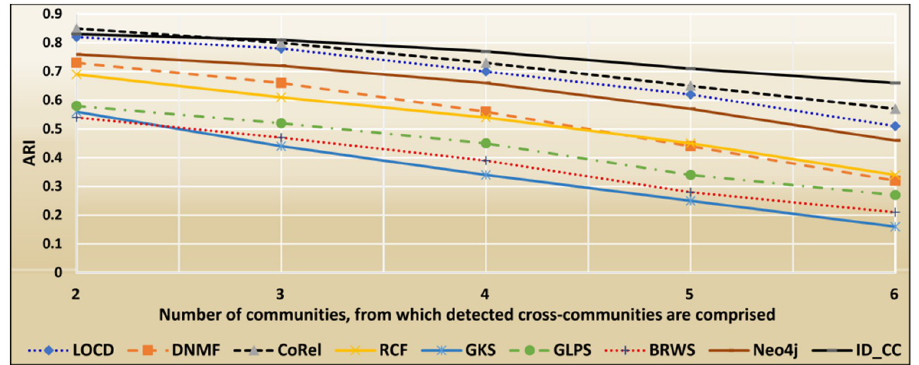
Fig 35. The average ARI for each group of detected cross-communities, where each group contains cross- communities comprised of the same number of single-attributed communities.